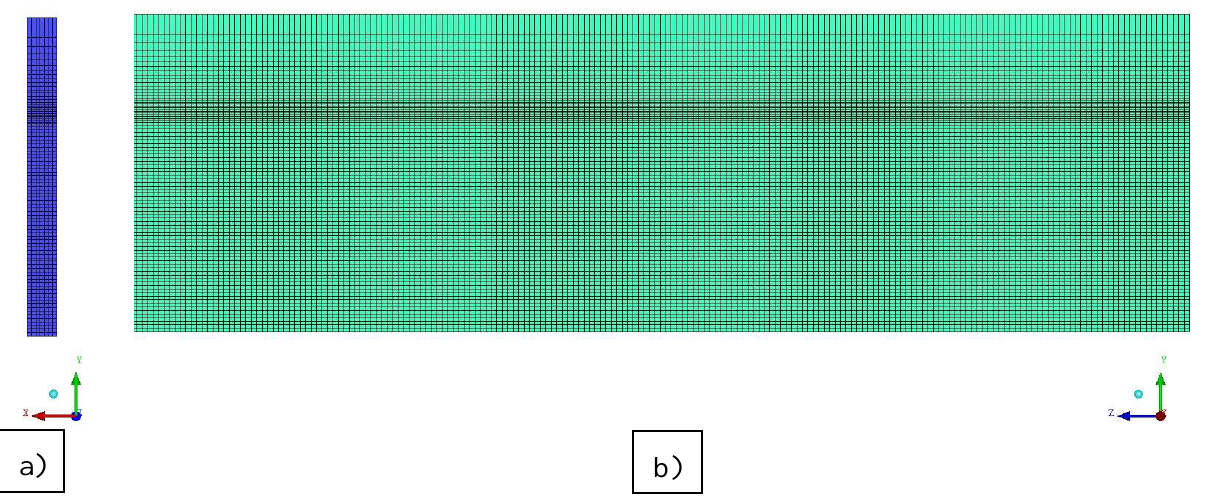
Figure 6. Final mesh selection using 120 cells per wavelength and 10 cells over the wave height: (a) in the XY plane; (b) in the YZ